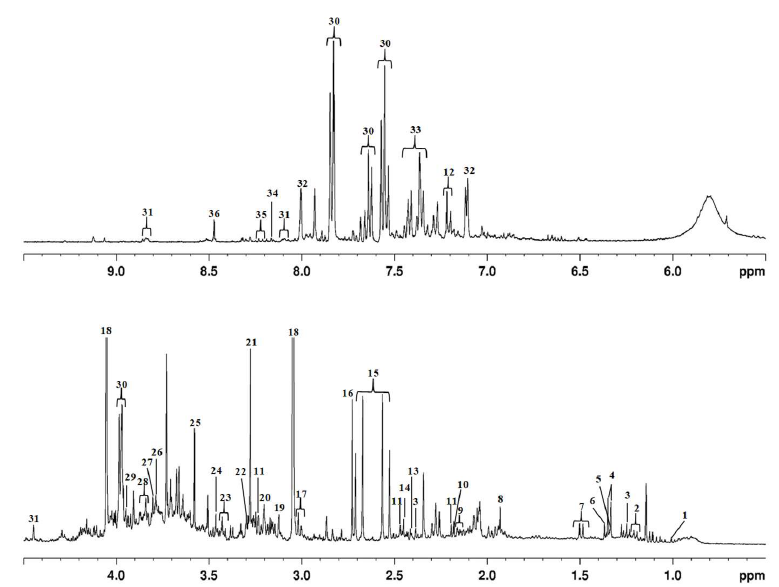
Figure 1. Typical 400 MHz representative urine 1 H NMR spectrum from a BC patient, referenced to TSP (δ 0.00 ppm). For peak identification please see Table 2.